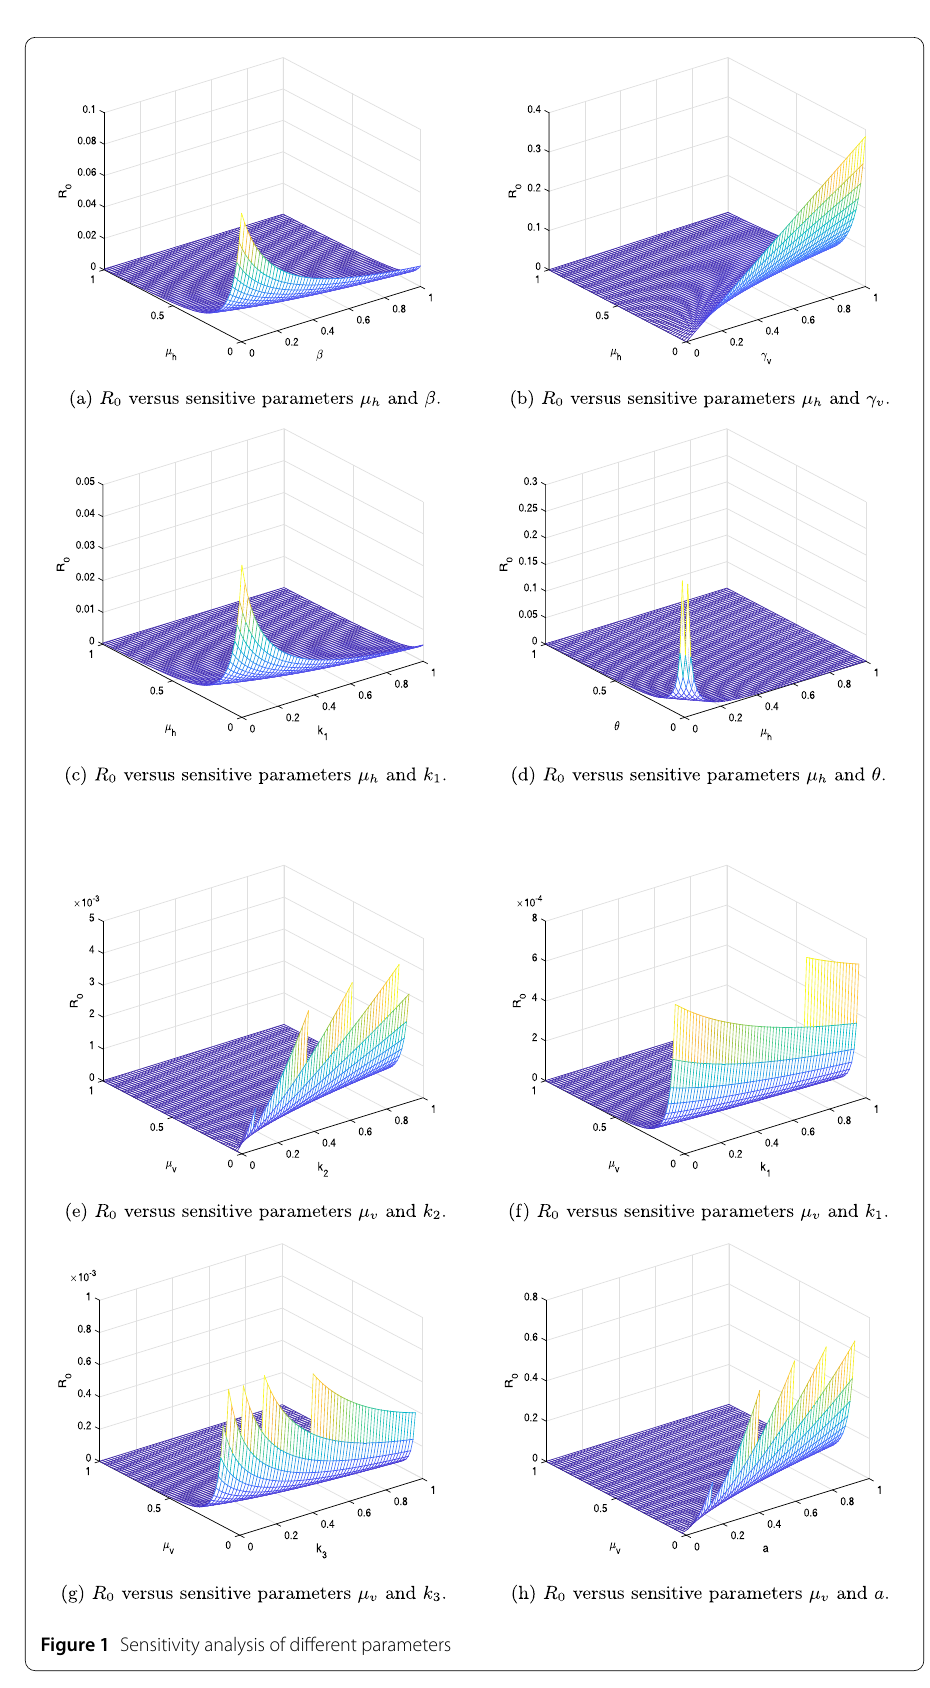
Figure 1 Sensitivity analysis of different